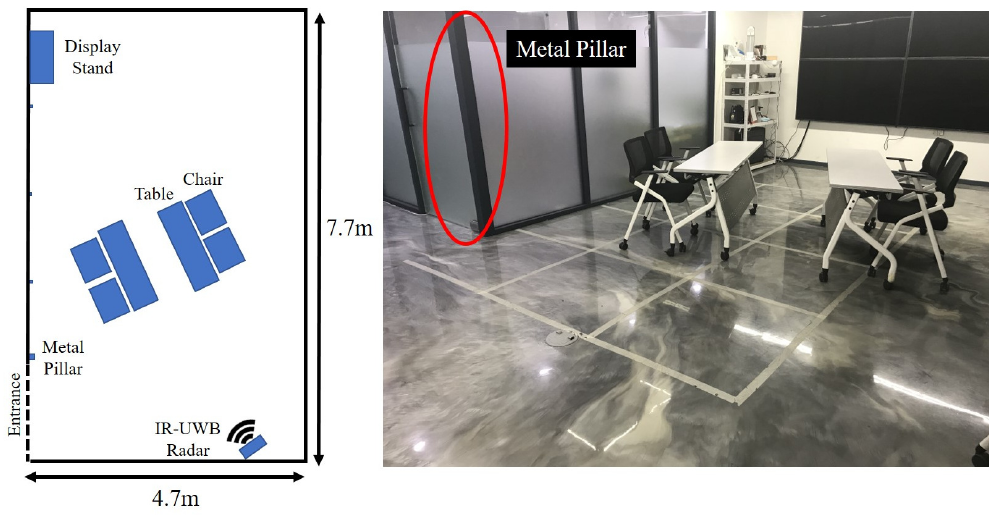
Figure 7. Light clutter